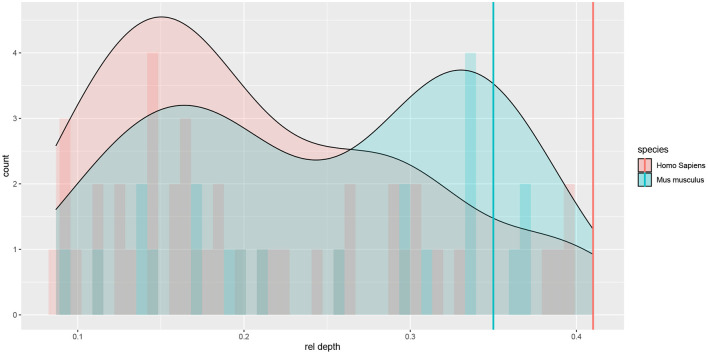
Histograms and density plots of the cells' relative (to pia and white matter) cortical depth. Depths close to 0 denote superficial cells. Vertical lines denote rough estimates of the boundaries of L4 in the two species, given by the cortical depth of the most superficial L4 cell that we observed among Allen Cell Type Database neurons.